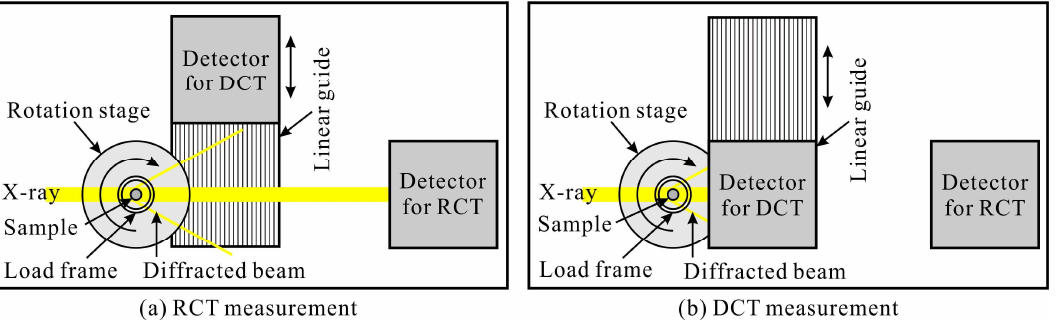
Figure 3. Schematic of dual camera measurement system.